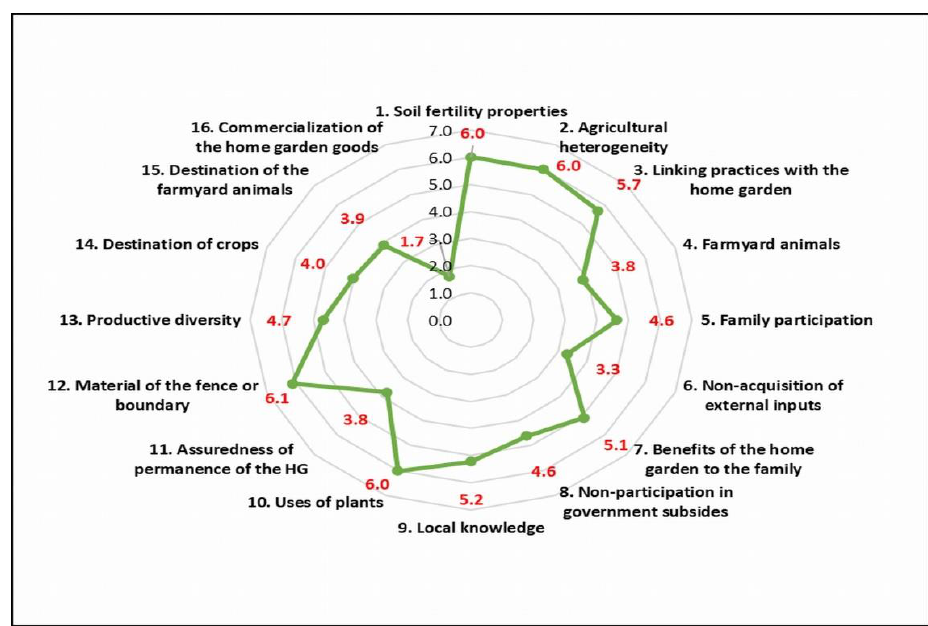
Figure 7. Average value per indicator of home gardens with strong sustainability.